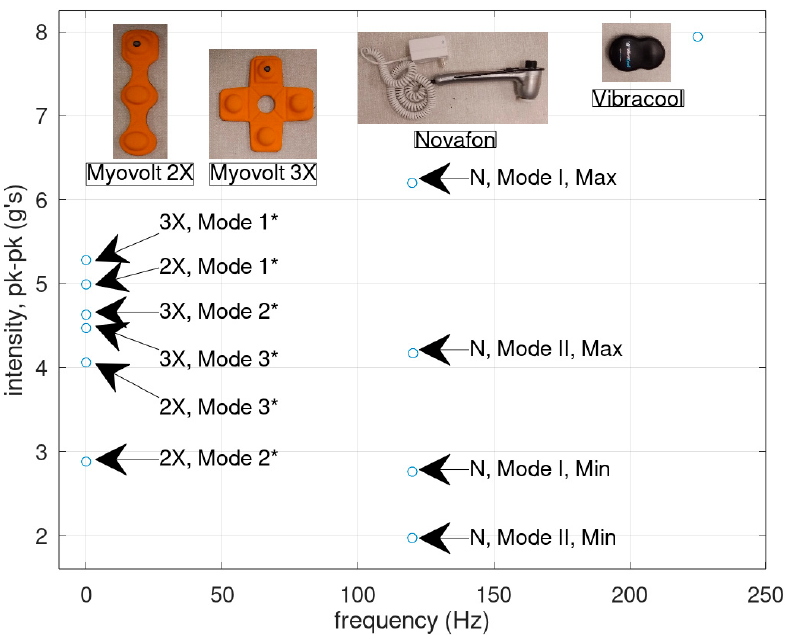
Figure 5. Frequency and peak-to-peak intensity vibration measured for the four focal vibration (FV) devices in the free vibration setup. “*” indicates that the maximum peak-to-peak intensity was measured, and that vibration frequency was not